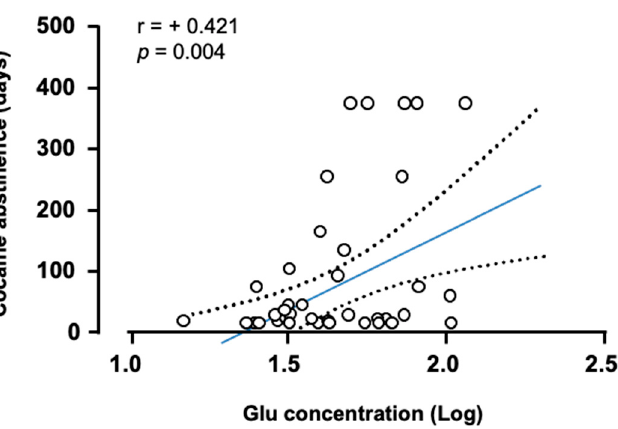
Figure 3. Correlation between plasma Glu concentrations and duration of cocaine abstinence. Correlation analysis was performed using the Pearson’s correlation coefficient ( r ) between log 10 -transformed concentrations of Glu and days of cocaine abstinence. Dots are individual values. Blue solid line and black dashed lines represent linear fit and 95%CI, respectively.